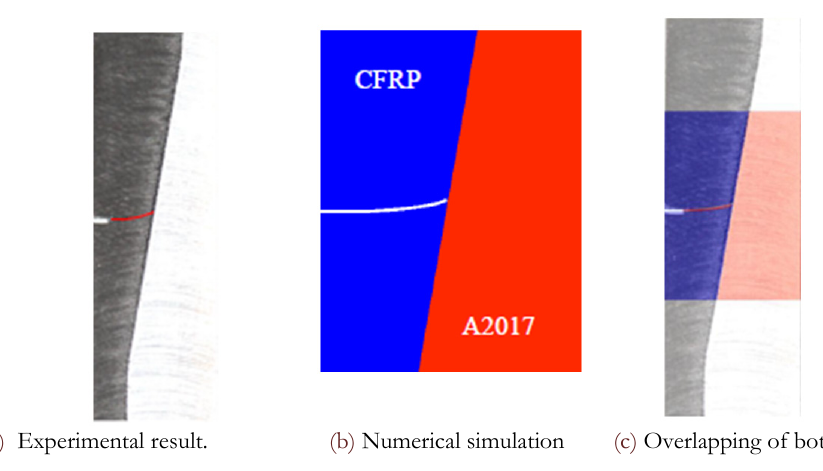
Figure 5: Comparison of crack path in